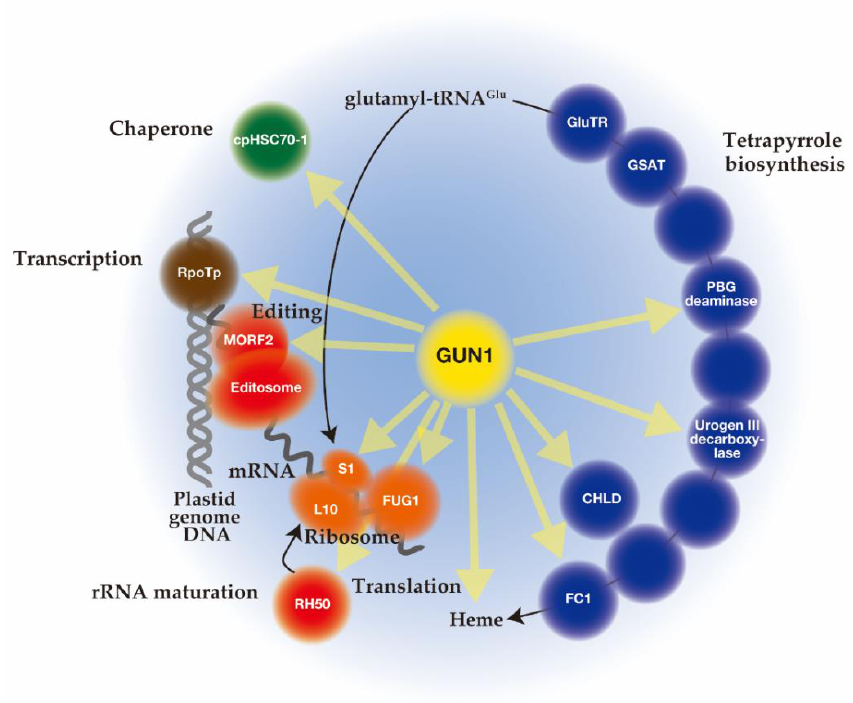
Figure 2. Schematic overview of genomes uncoupled (GUN)1 interacting proteins involved in plastid protein homeostasis (transcription (brown circles), editing and maturation (red circles), trans- lation (orange circles), and chaperone (green circles)) and tetrapyrrole biosynthesis (blue circles). Yellow arrows indicate GUN1 interactions. It is possible that through the N-terminal intrinsically disordered region (IDR) region or pentatricopeptide repeat (PPR) domain, GUN1 forms a droplet that causes molecular crowding, which enhances entropically favor molecular association events, thereby accelerating molecular reactions. Interactions of GUN1 with indicated proteins were demon- strated by co-immunoprecipitation, bimolecular fluorescence complementation (BiFC), and yeast two-hybrid